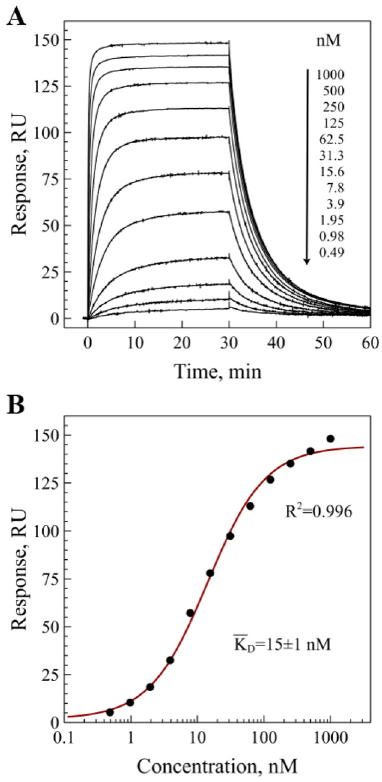
Figure 2. Binding of BCD090-M2 VHH antibody to the extracellular domain of human ErbB3 receptor analyzed by surface plasmon resonance. The purified extracellular domain (residues 21-643) was immobilized on CM5 chip surface.